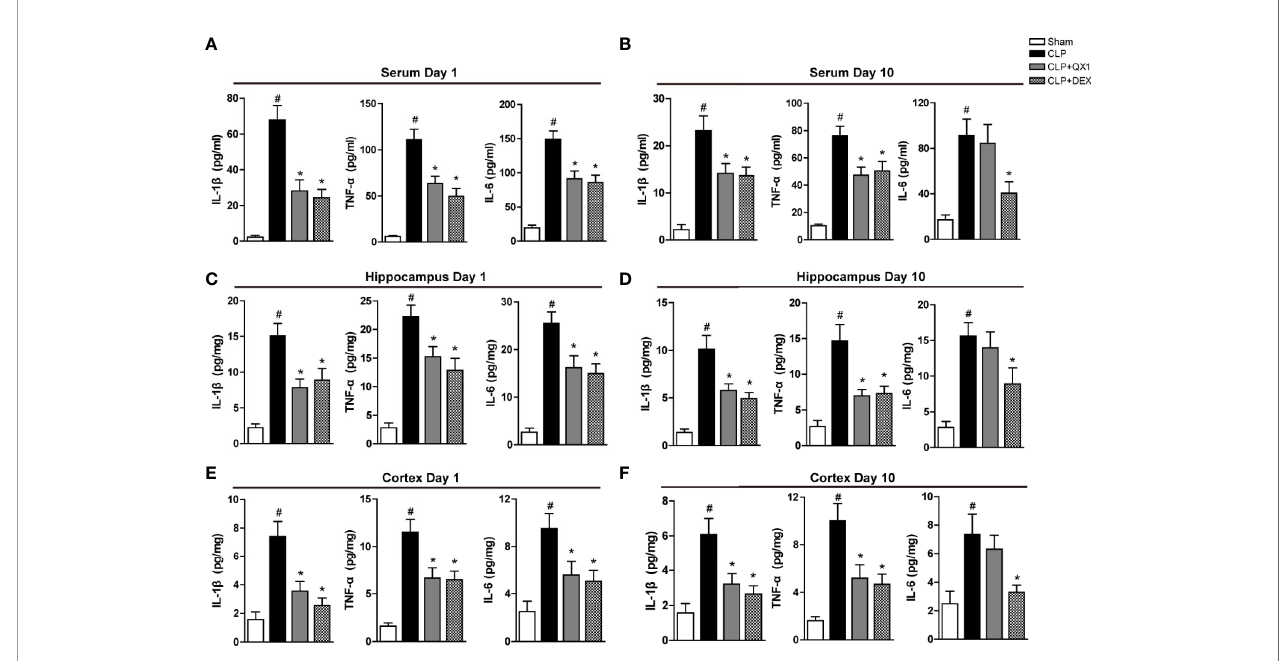
FIGURE 5 | QX1 formula ameliorates peripheral and central in fl ammatory responses in septic mice. Mice were randomized divided into sham, CLP, CLP treated with QX1 formula, and CLP treated with DEX groups. Mice were treated with QX1 formula (2 g/kg) or DEX (1 mg/kg) beginning at 2 h after CLP surgery. DEX was used as a positive control. Levels of in fl ammatory factors were determined by ELISA. Levels of TNF- a , IL-1 b , and IL-6 at day 1 (A) and day 10 (B) in serum of septic mice. Levels of TNF- a , IL-1 b , and IL-6 at day 1 (C) and day 10 (D) in the hippocampus of septic mice. Levels of TNF- a , IL-1 b , and IL-6 at day 1 (E) and day 10 (F) in the frontal cortex of septic mice. Data were shown as mean ± SD (on day 1, n=12-15 per group; on day 10, n=15 per group). # p < 0.05 vs. sham, * p < 0.05 vs. CLP, one-way ANOVA. CLP, Cecal Ligation and Puncture; QX1, Qiang Xin 1; DEX,